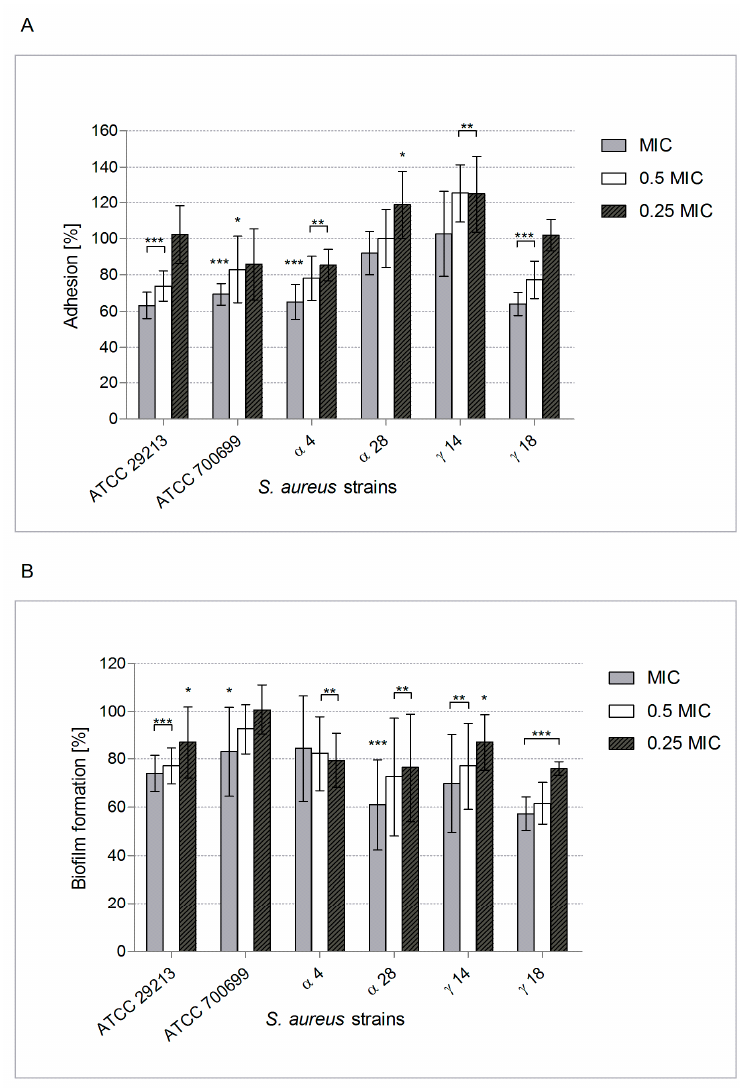
Figure 2. Adhesion ( A ) and biofilm formation ( B ) by S. aureus reference and clinical strains (n = 2 + 4) on mucin- conditioned surface, in the presence of POE used at MIC, 0.5 × , 0.25 × MIC, tested by LIVE/DEAD BacLight Bacterial Viability Kit. The percentage of adhered cells or biofilm biomass compared with positive control (untreated bacteria) considered as 100% is presented. Significant differences: * p ≤ 0.05, ** p ≤ 0.01, *** p < 0.001.